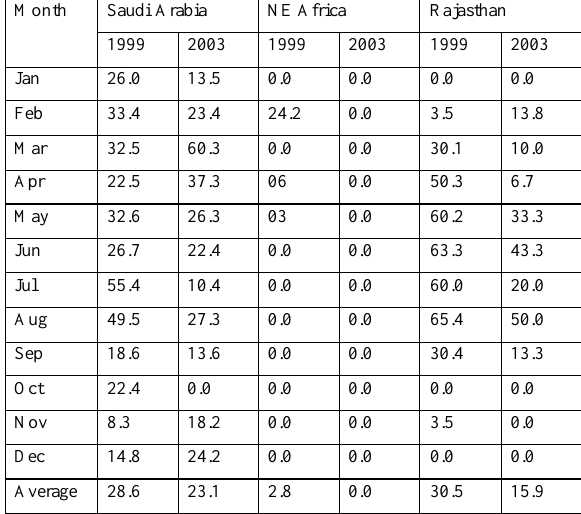
Table 1. Comparison of Frequency of Occurrence of Wind (%).